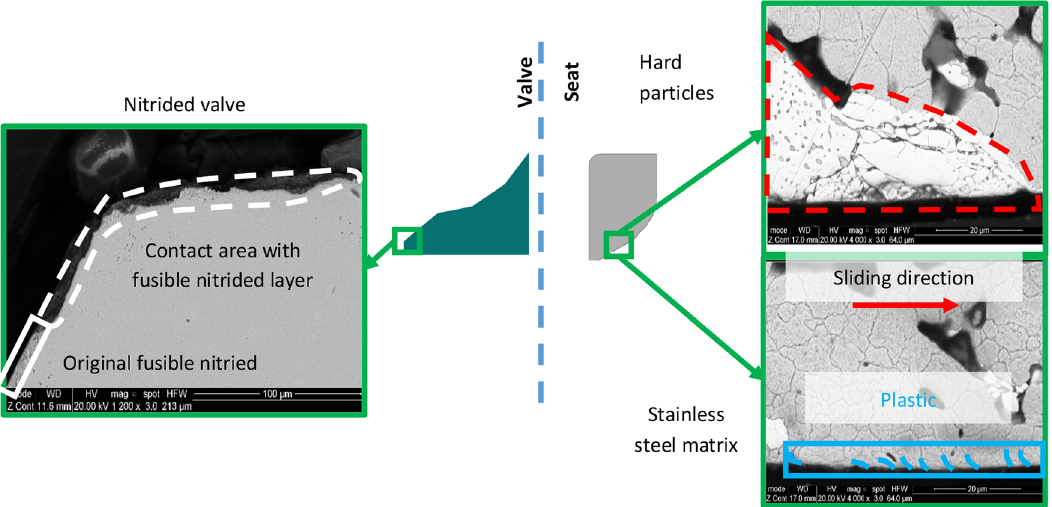
Fig. 17. Sample cuts made after 1000 hours of testing.